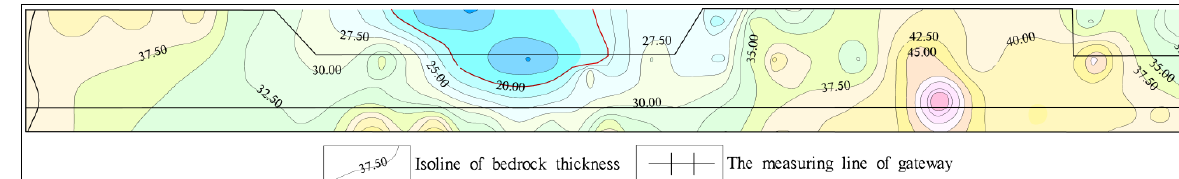
Figure 4. Contour map of bedrock thickness.